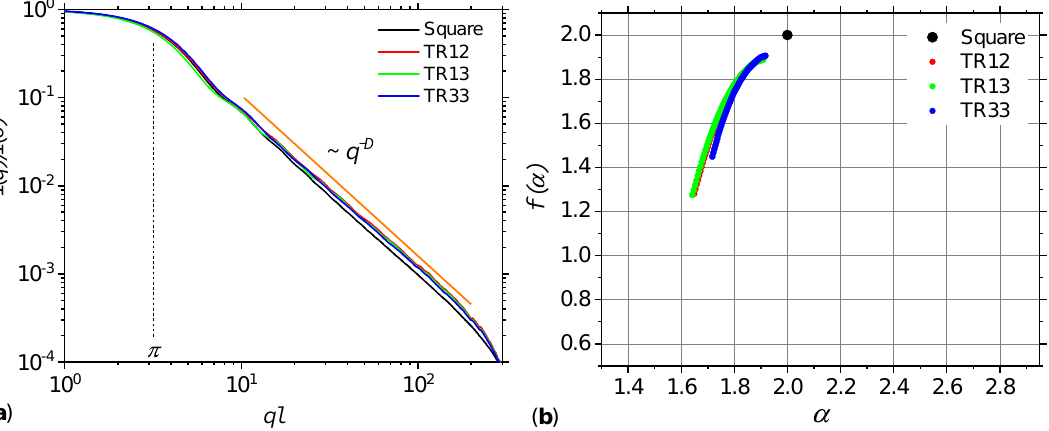
Figure 9. Scattering intensities ( a ) and f ( α ) spectra ( b ) for models TR12, TR13 and TR33. l is the overall size of the “ACGT” square. The data for a uniform square are included for